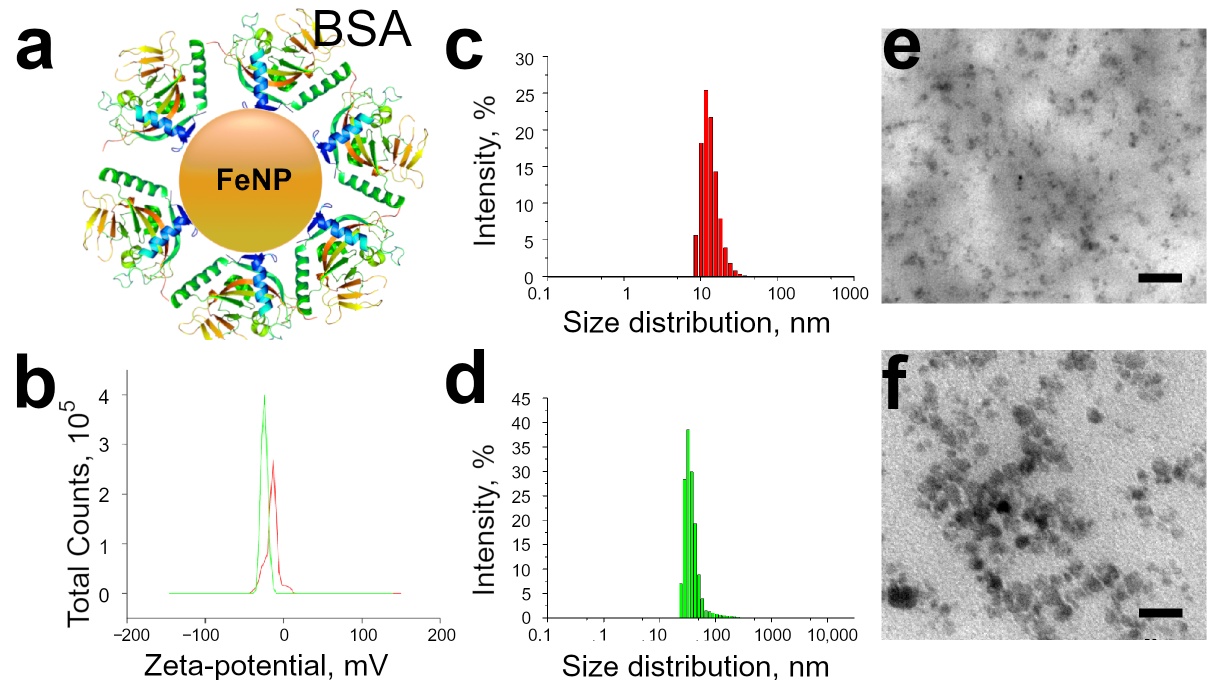
Figure 1. ( a ) Schematic illustration of the FeNP-BSA. ( b ) ζ -potential of non-labeled (red) and BSA- labeled (green) FeNP. Size distributions of ( c ) non-labeled and ( d ) BSA-labeled FeNP. TEM images of magnetic nanoparticles ( e ) before and ( f ) after BSA conjugation. Scale bars are 50